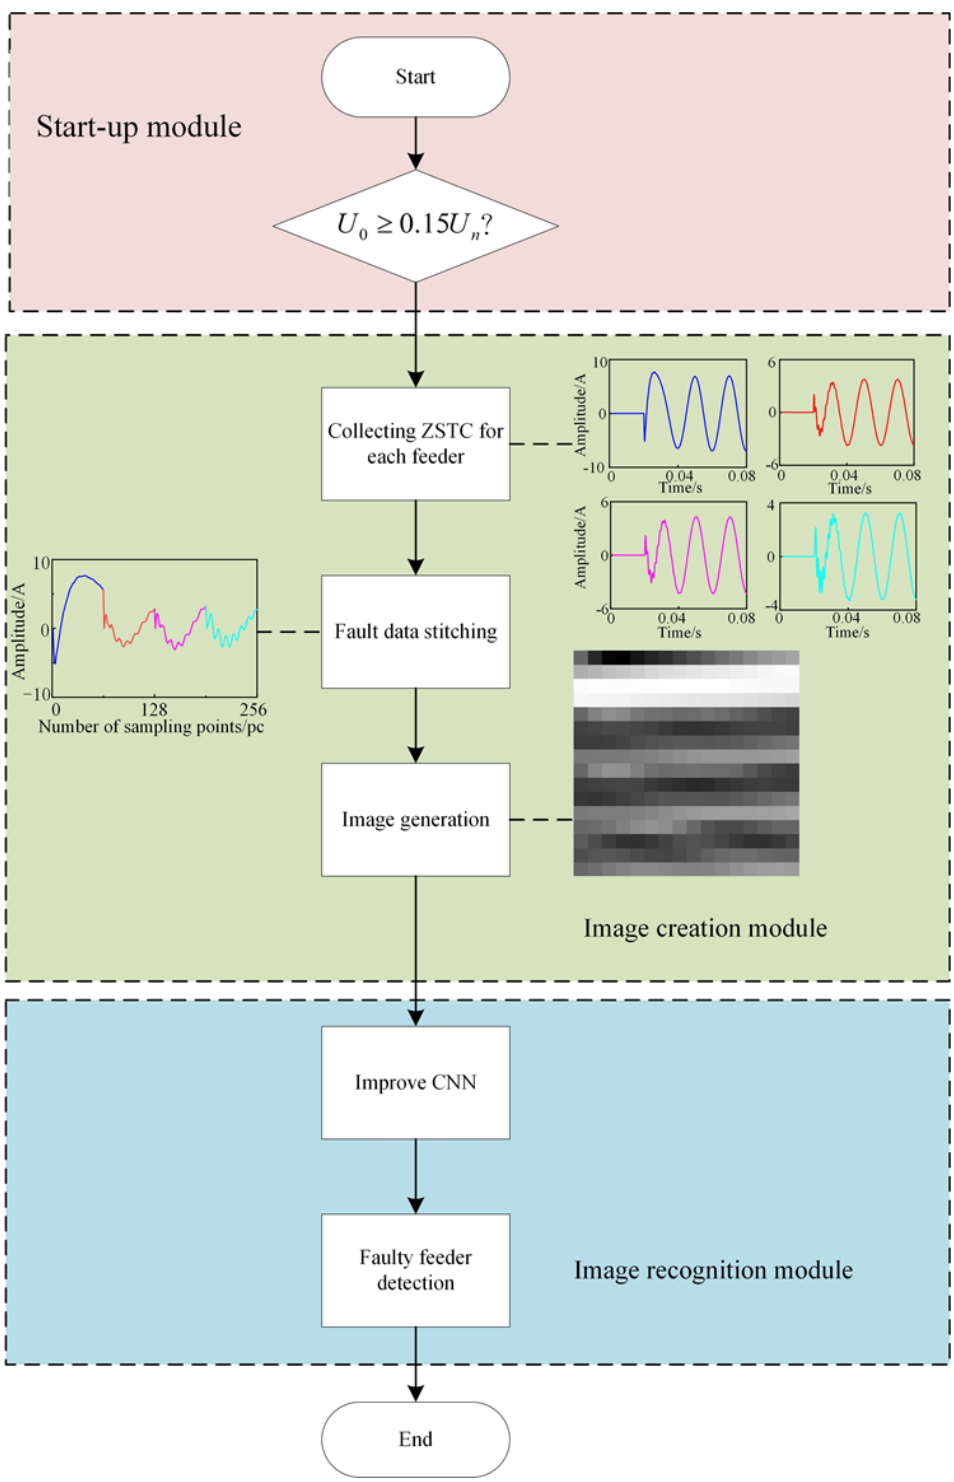
Figure 3. Proposed fault detection framework.